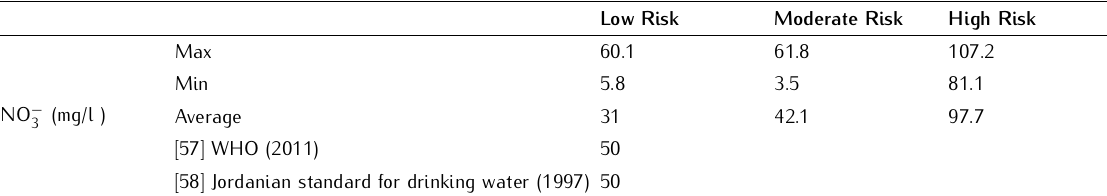
Table 11. Maximum, minimum, and average NO −